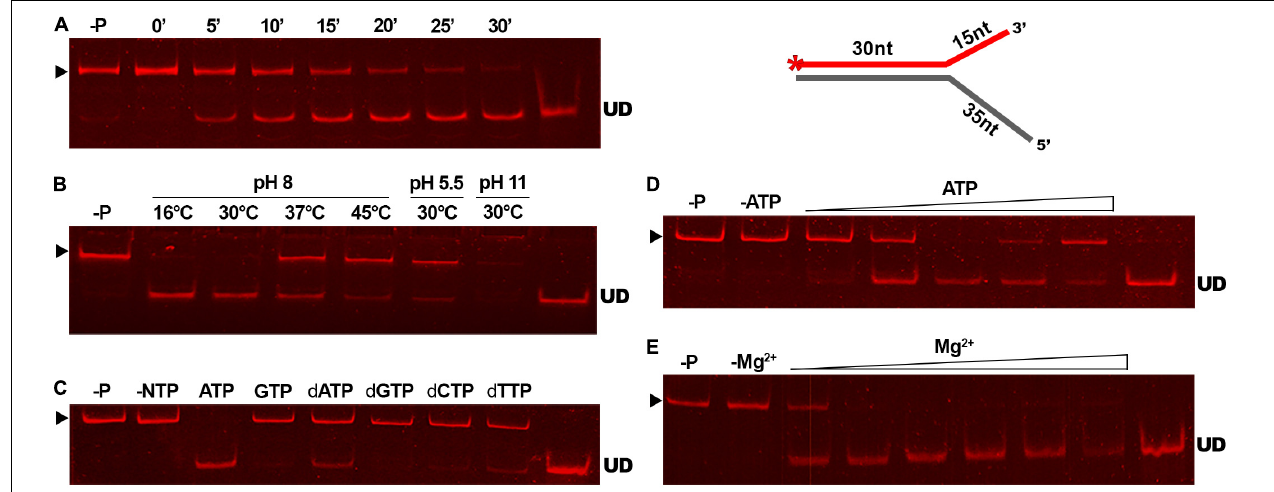
FIGURE 6 | The unwinding activity of GP46 F 13 under different reaction conditions. The GP46 F 13 protein (0.5 µ M) and Cy5-labeled branched substrate (1.5 nM) with extended 5 (cid:48) tail (30duplex_5 (cid:48) ext) were incubated under varying conditions: time (0, 5, 10, 15, 20, 25, 30 min) (A) ; temperature (16 ◦ C, 30 ◦ C, 37 ◦ C, 45 ◦ C) and pH (5.5, 8.0, 11) (B) ; NTPs or dNTPs (5 mM) (C) ; ATP (0, 1, 2, 5, 10, 15 mM) (D) ; and MgCl 2 (0, 1, 2, 5, 10, 15, 20 mM) (E) . Reaction samples were analyzed on native 15% polyacrylamide gels. –P; control reaction without protein. –NTP/–ATP; control reaction without NTPs/ATP. –Mg 2 + ; control reactions without Mg 2 + . (cid:73) indicates the expected migration of the substrate; UD indicates the expected migration of the unwound DNA (Cy5-labeled oligonucleotide) marked on the scheme in red and with an asterisk.